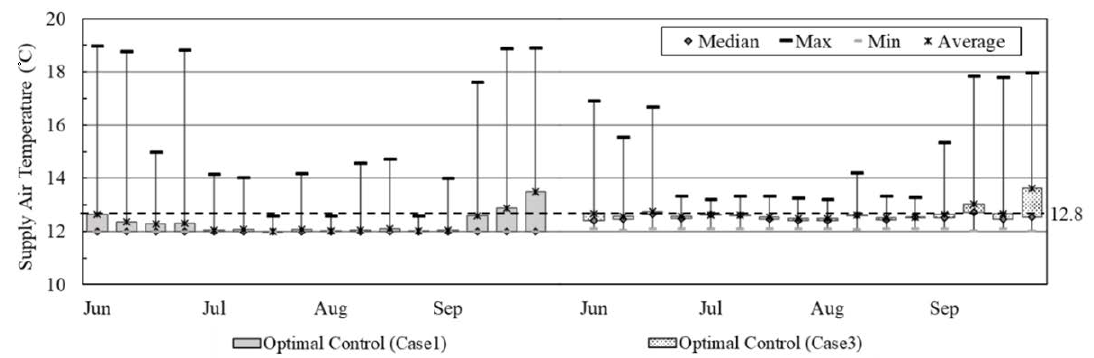
Figure 4. Supply air temperature changes during optimal control mode for June through to September.